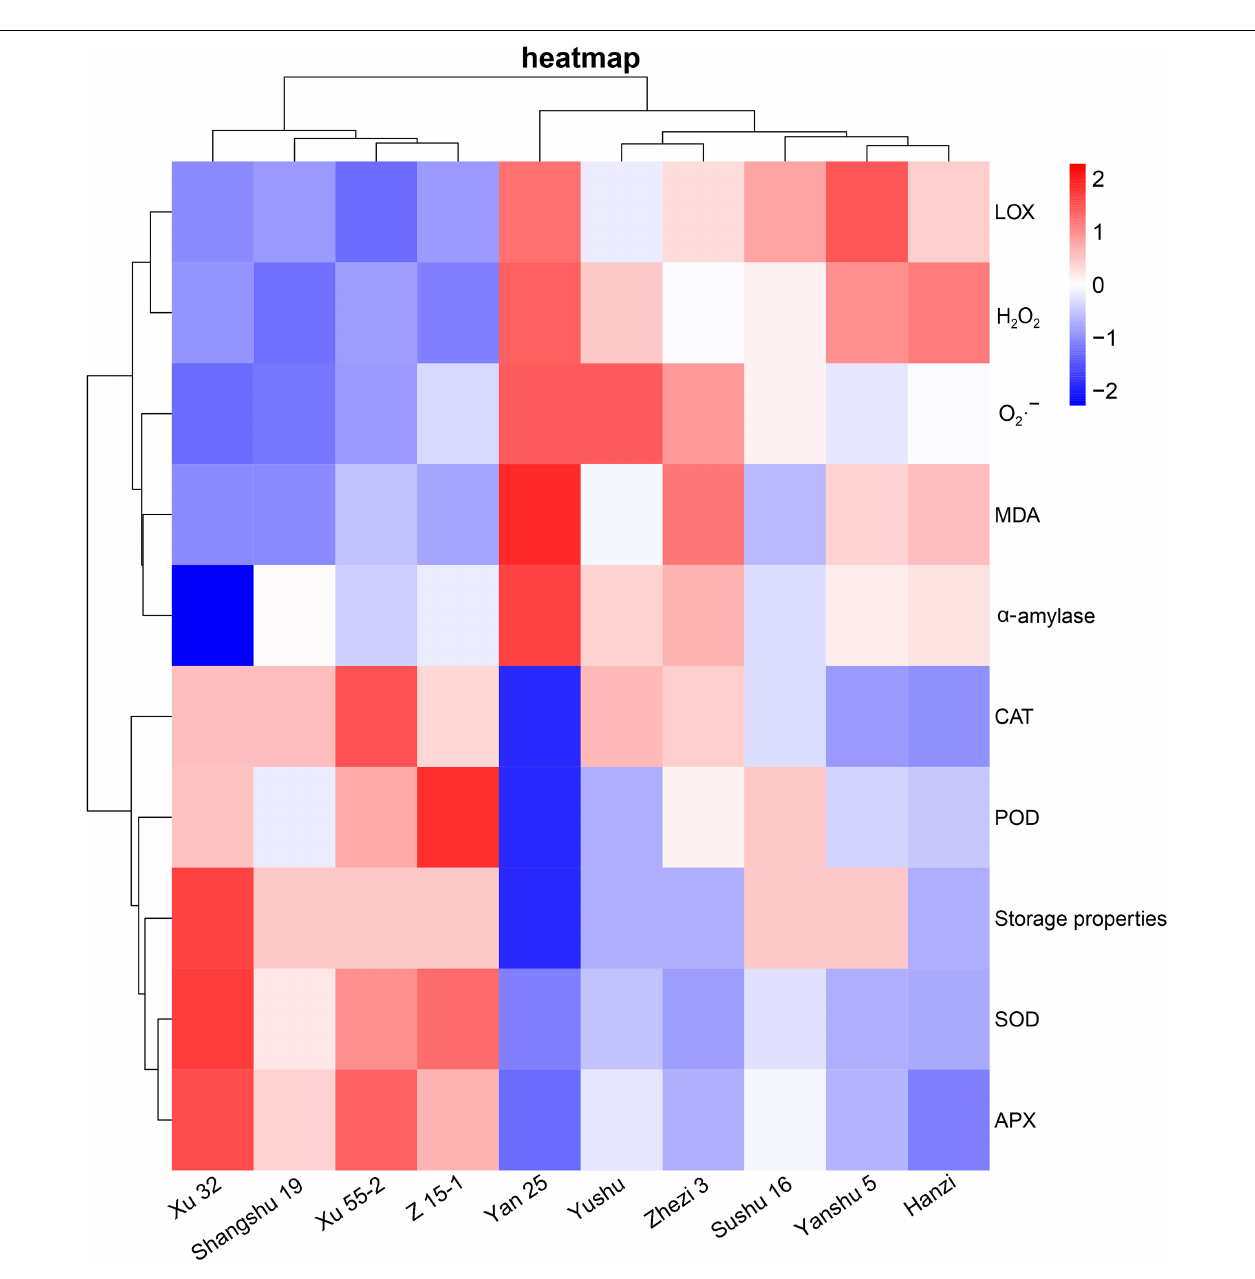
FIGURE 6 | Heat map analysis of antioxidant enzyme (i.e., SOD, POD, APX, CAT), α -amylase, and LOX activities and ROS-related indexes (i.e., O 2 · − , H 2 O 2 , and MDA) in 10 sweet potato cultivars (i.e., Xu 32, Xu 55-2, Z15-1, Shangshu 19, Sushu 16, Yanshu 5, Hanzi, Yushu, Zhezi 3, and Yan